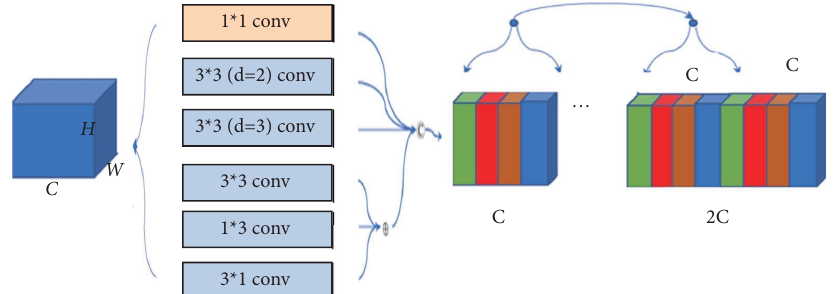
Figure 3: MS branch structure diagram.